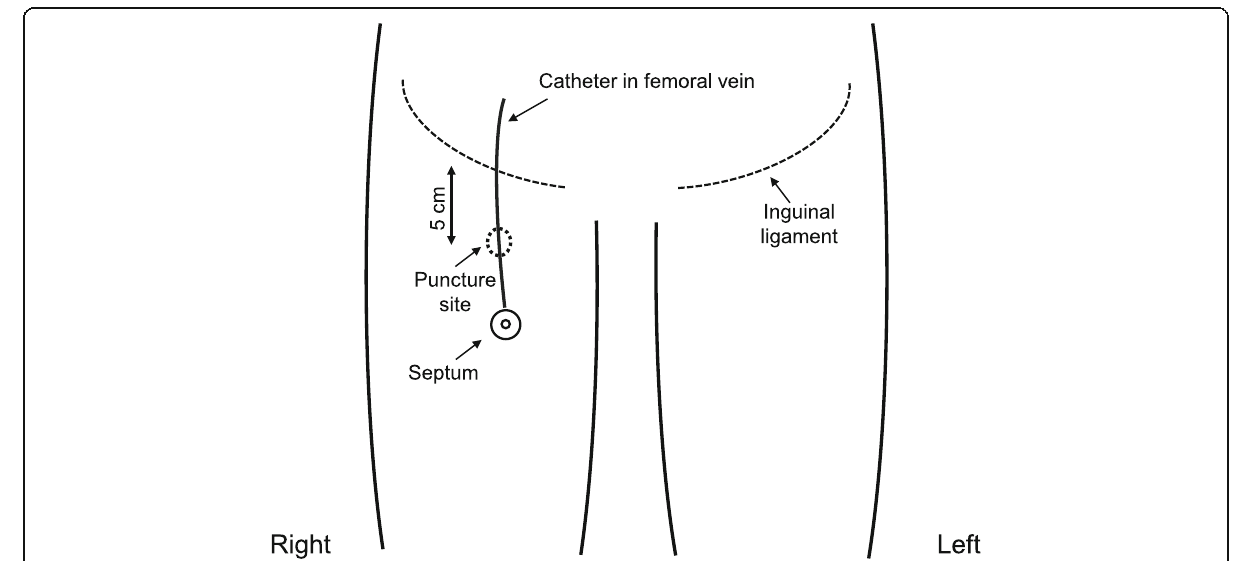
Fig. 1 The implantation site of totally implantable venous access port (TIVAP). TIVAP was implanted via the right femoral vein by ultrasound- guided procedure with “ Out-of-plane ” puncture. The right femoral vein was punctured percutaneously about 5 cm distal to the inguinal ligament. The TIVAP septum was placed in a subcutaneous pocket at the proximal anterior